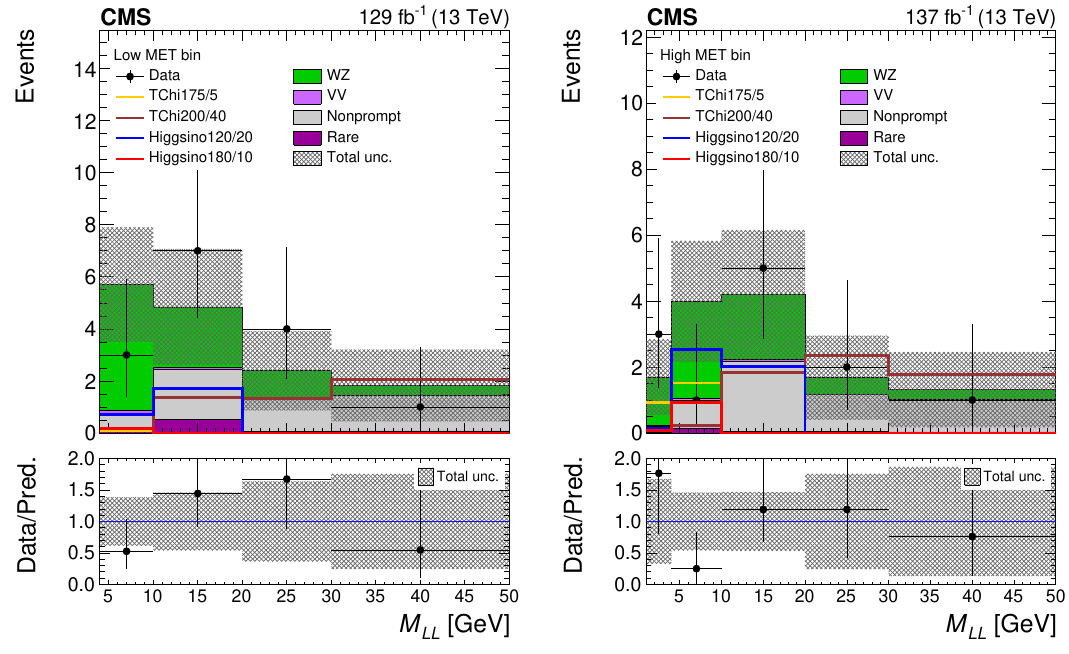
( ‘‘ ) variable is shown SFOS eigenvalues is positive m m 0 0 e e e c e c 1 2